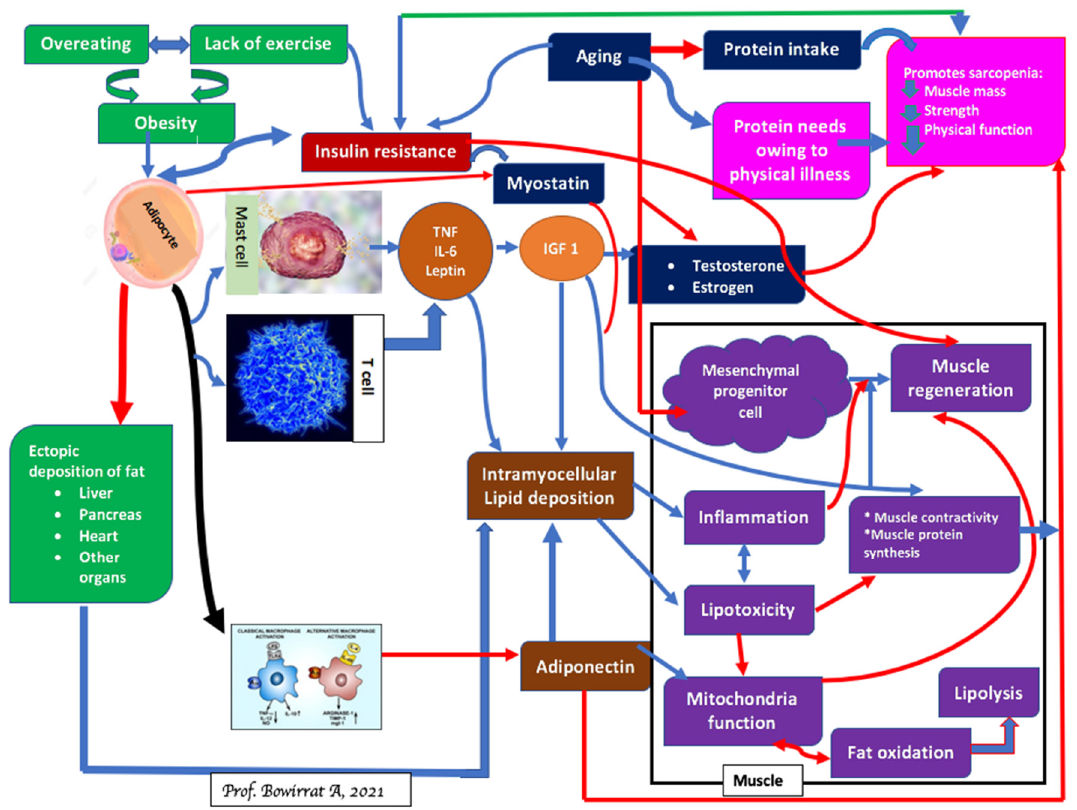
Figure 5. A proposed model of mechanisms leading to sarcopenic obesity.